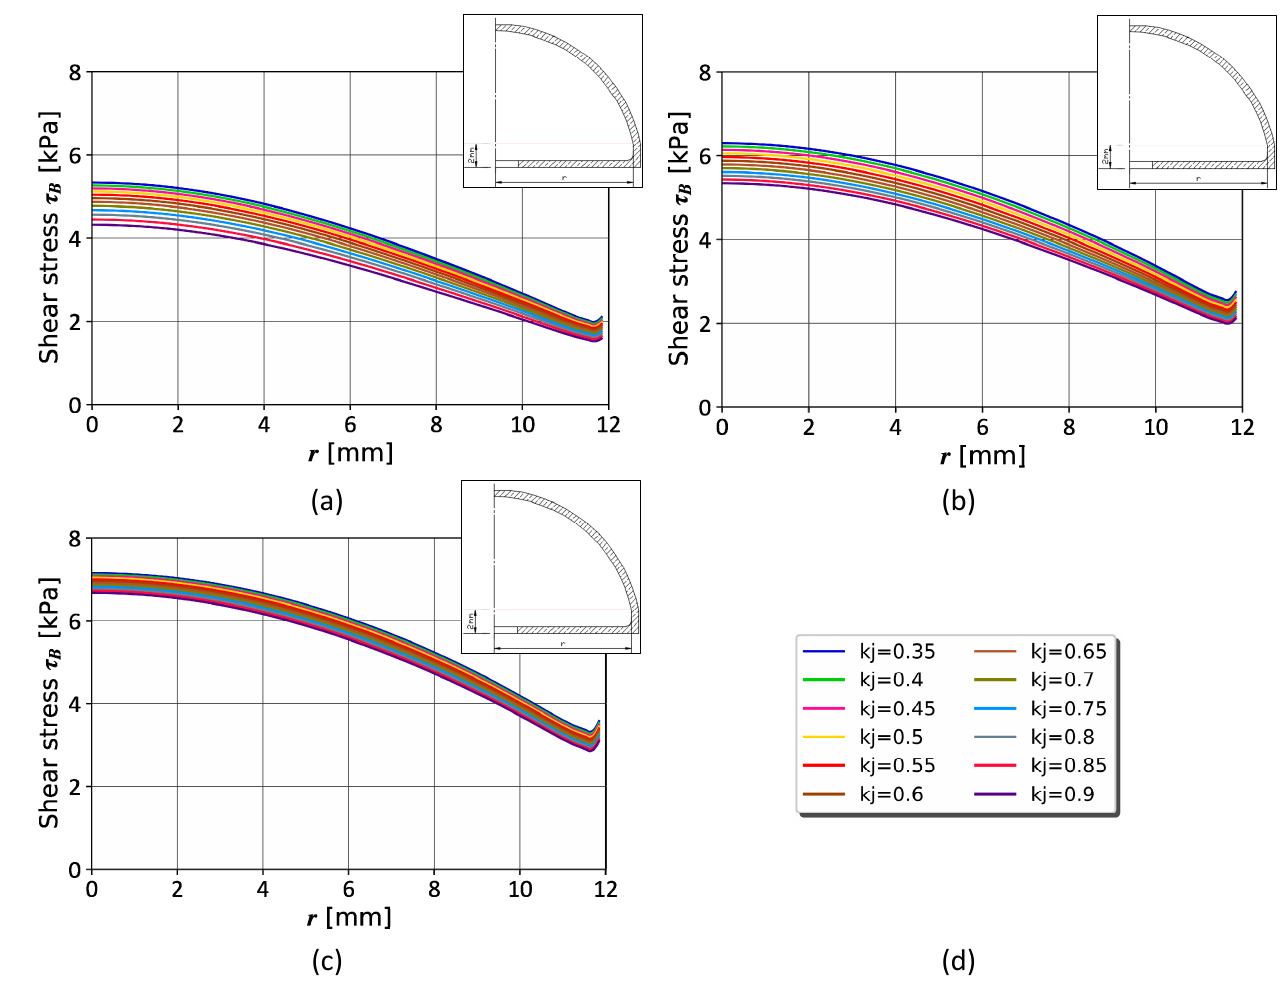
Figure 12. Shear stress τ B distribution for Instance 1 distance z = 10 mm and thickness gm = 6 mm using different configurations of the kj coefficient for kpm equal to: ( a ) 0.7; ( b ) 0.8; ( c ) 0.9; ( d ) legend.